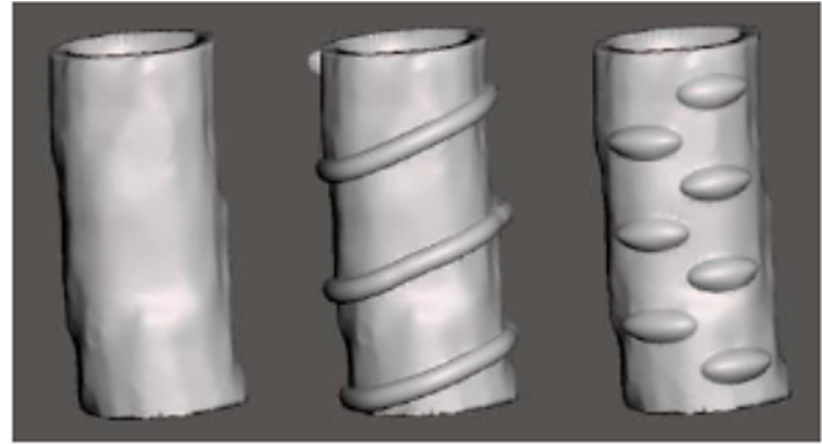
Figure 7. 3D models for tracheal stents (Reprinted from an open-access source) [138].